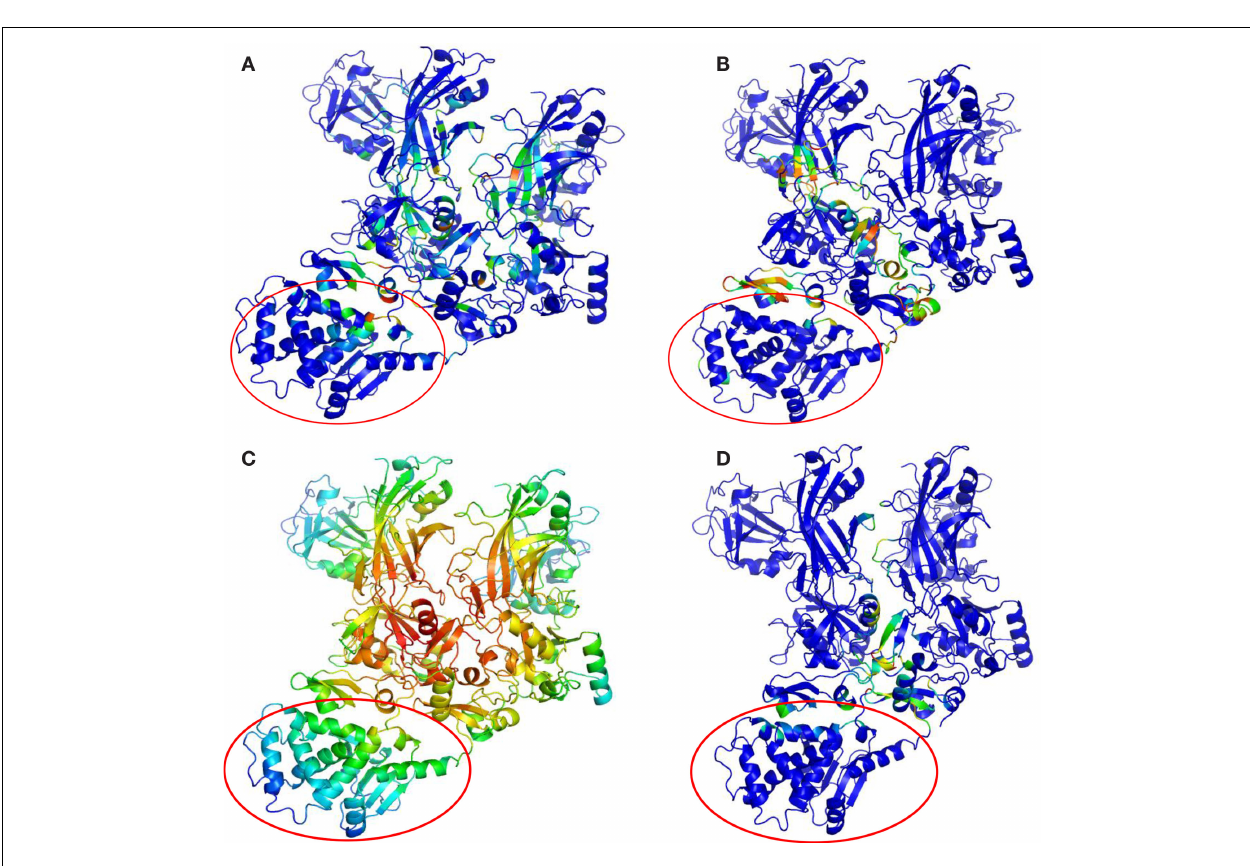
Frontiers in Bioengineering and Biotechnology |